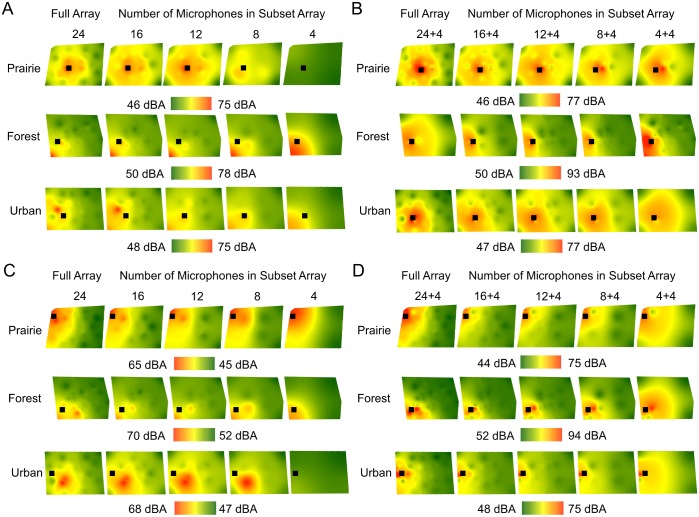
Examples of sound maps illustrating overall SPLs (dBA) during noise introductions (■) in three habitats.Maps show noise introduction within arrays without (A) and with (B) additional microphones around noise source, and noise introduction at the edge of arrays without (C) and with (D) the additional microphones. Within habitat, maps in (A) and (B) illustrate the same randomly selected locations and time points, as do (C) and (D). Arrays are the same as those shown in Fig 3. Note that the ranges and values of SPLs differ among maps.